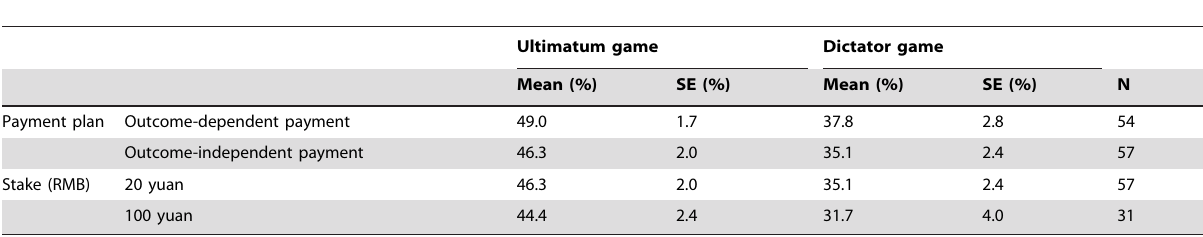
Table 1. Participants’ offers (in percent) in the ultimatum game and the dictator game in the pilot studies.